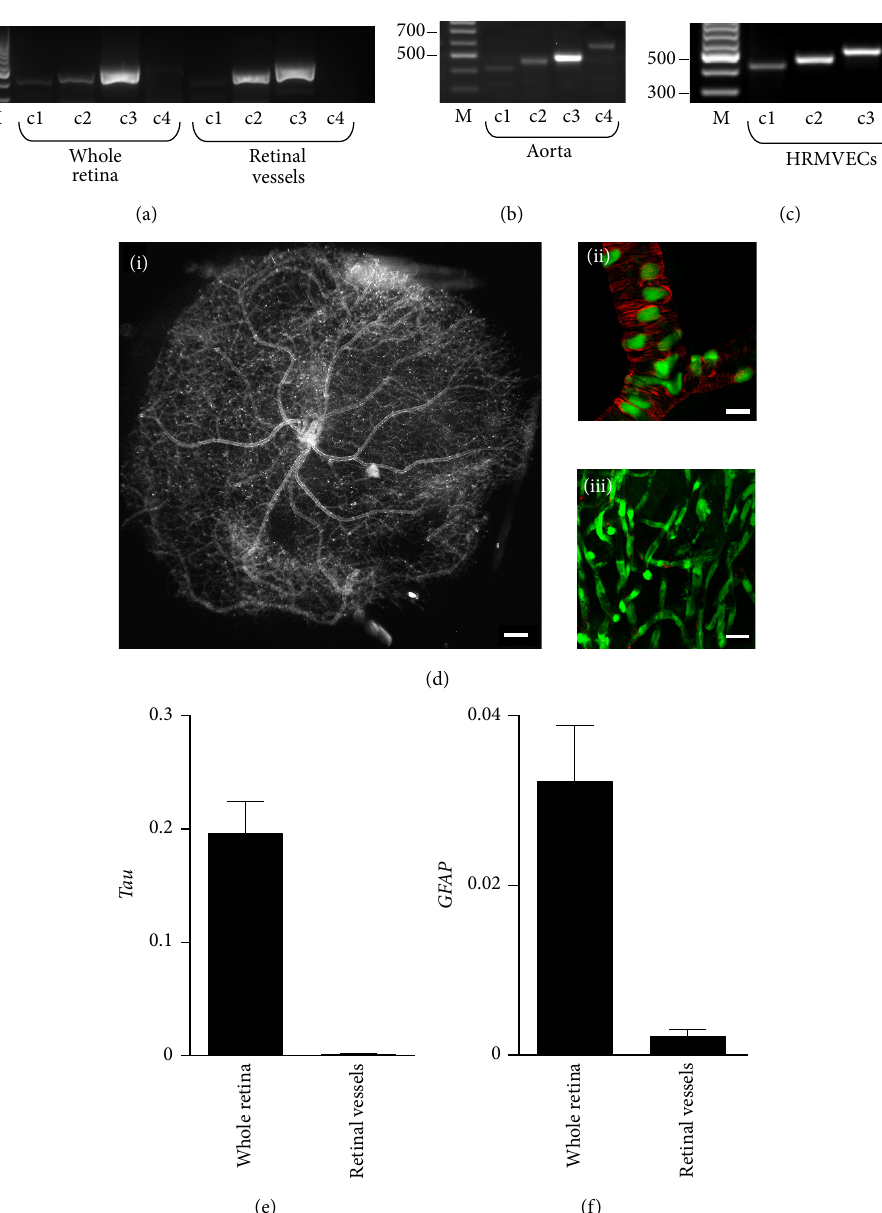
Figure 1: Expression of NFATc transcription factor genes in whole retina and in retinal microvessels. (a) RT-PCR analysis of NFAT isoform (c1–c4) expression in whole retinas and isolated retinal vessels from nondiabetic FVBN mice ( 𝑁 = 8 ). ((b)-(c)) All NFAT family members are expressed in mouse aorta (b) and in cultured human retinal microvascular endothelial cells (HRMVECs, (c)). Markers (M) for 300, 500, and 700bp are indicated. (d)(i) Dark field/side illumination of a vascular network isolated from whole retina as described in material and methods (Section 2.2). (d)(ii) Confocal image showing smooth muscle 𝛼 -actin positive staining (red) and nuclei (green) of an isolated retinal vessel preparation. Note the lack of surrounding nonvascular tissue (black background). (d)(iii) Confocal image of a smaller caliber vessel network stained as in (d)(ii) showing the absence of smooth muscle 𝛼 -actin positive cells. Scale bars = 500 𝜇 m for (d)(i); 20 𝜇 m for (d)(ii)- (d)(iii). (e)-(f) Quantitative RT-PCR data showing expression levels of neuronal maker Tau (e) and glial marker GFAP (f) in whole retina and in isolated retinal vessels, both normalized to 18S. 𝑁 = 6